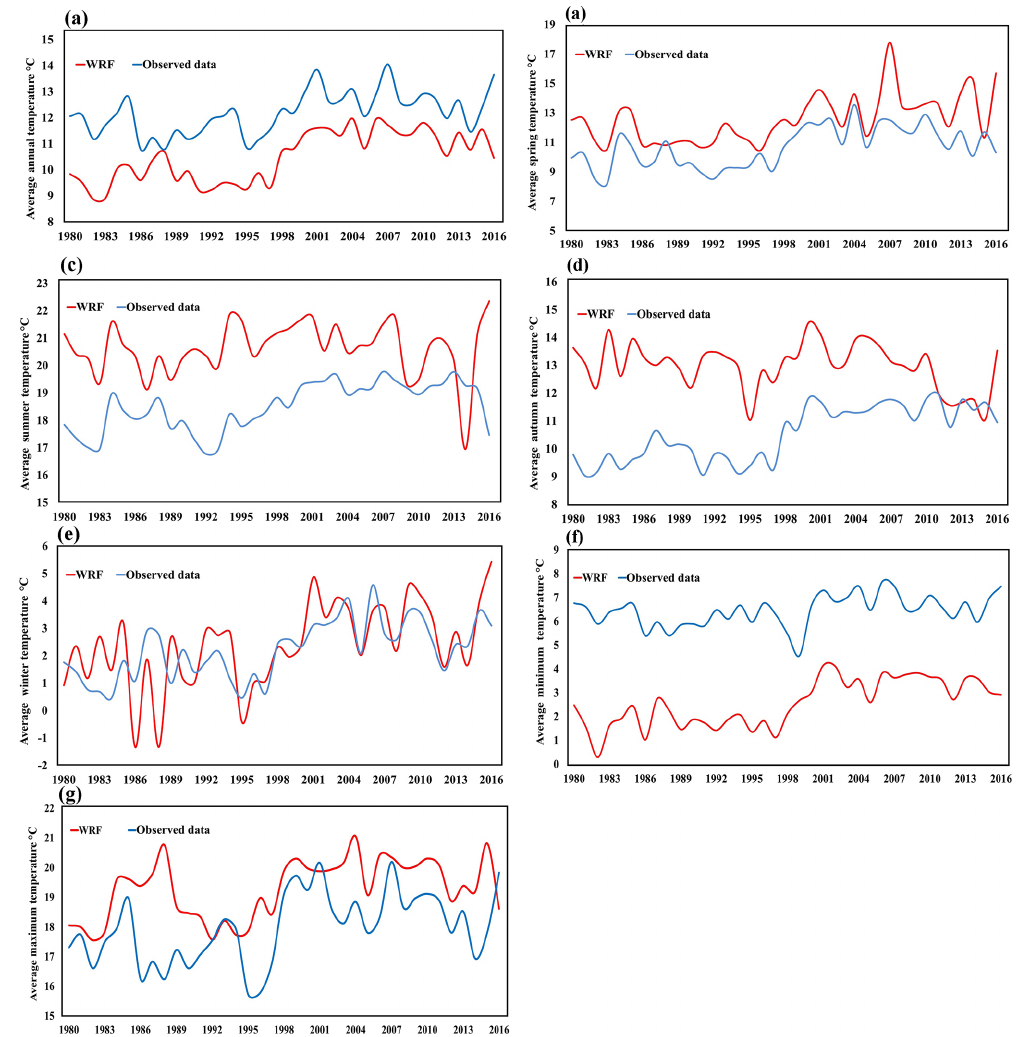
Figure 5. (a) Comparision between observed and WRF model (location of Kokarnag is considered) simulated annually averaged temperature (averaged for all the stations) variations for the years 1980–2016, (b) same as (a) but for spring season, (c) for summer, (d) for autumn, (e) winter, (f) for minimum temperature and (g) maximum